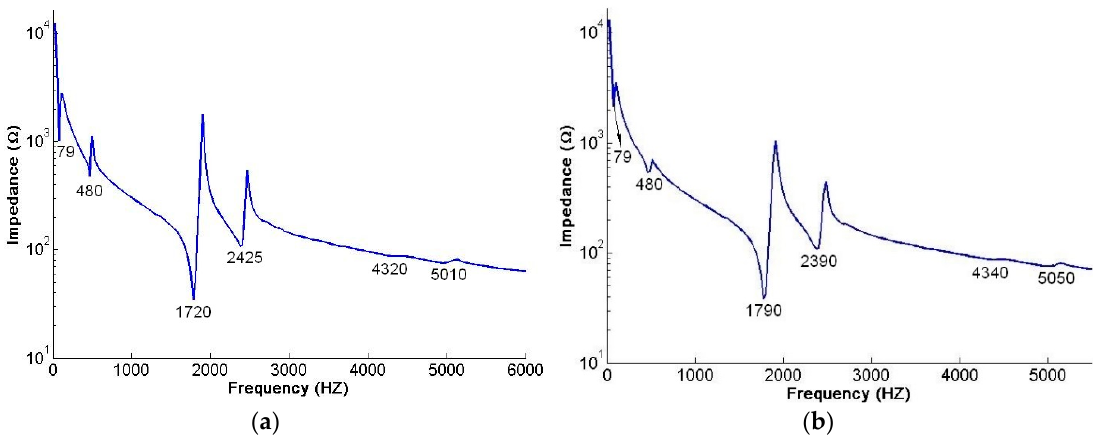
Figure 14. Impedance variation curve of air-coupled ( a ) anti-phase vibration and ( b ) in-phase vibration.